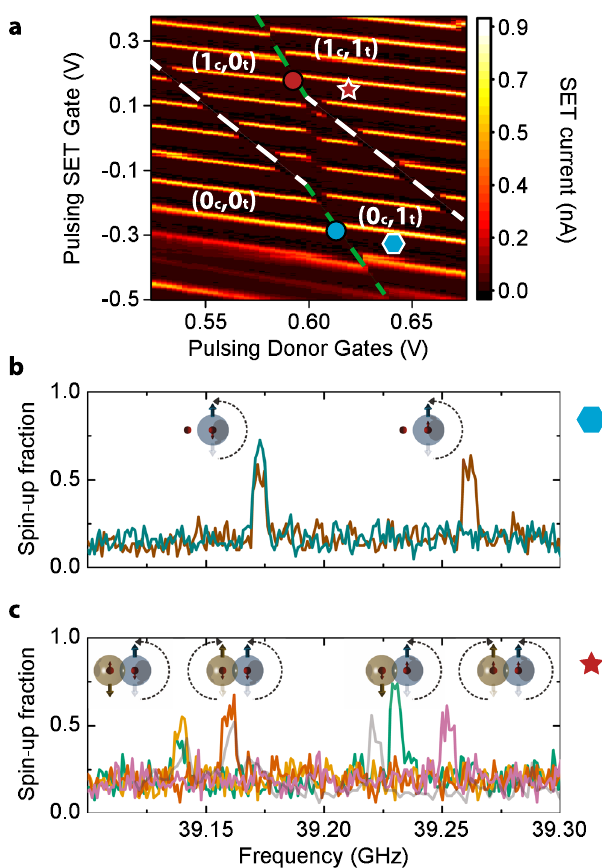
Fig. 4 Signature of exchange coupling between electron spins in a 31 P donor pair. a Charge stability diagram around two donor charge transitions, obtained by scanning the voltages on the pulsing SET and the pulsing donor gates (unlike Fig. 3b, where the DC gates were scanned, which have stronger capacitive coupling to the donors). A clear two-electron honeycomb diagram can be resolved. The dashed white lines follow the control donor transition, while the dashed green lines follow the target donor. The measurement demonstrates an access to all charge occupation regions. Blue and red circles mark the spin readout points for the target electron, while the blue hexagon and red star mark the spin control regions for different charge occupations. b ESR spectrum acquired in the (0 c ,1 t ) region (blue hexagon), i.e., with the control donor ionized. Only two ESR peaks arise, related to the nuclear spin con fi guration of the target donor. c If the ESR spectrum of the target donor is measured in the (1 c ,1 t ) region (red star), the exchange coupling with the control electron gives rise to the four main peaks ℓ 1 (yellow), ℓ 2 (red), ℓ 4 (green), and ℓ 5 (pink), corresponding to the four possible nuclear spin con fi gurations, while the control electron is # (cid:3) (cid:3) (cid:4) . In one scan (gray line), we observed the occurrence of the rare ℓ 5 a transition (see Supplementary Note an exchange interaction J between the two-donor electrons: the four ESR peaks correspond to the four possible orientations of the two donor nuclear spins, while the control donor is in the # j i state ( ℓ 1, ℓ 2, ℓ 4, and ℓ 5). Observing all six main ESR lines would normally require preparing the control donor electron in the " j i state, which was not attempted in this experiment. Here, the nuclear spins ’ state was not deliberately controlled, but all spin con fi gurations were eventually reached through random nuclear fl ips. In one occasion, we also detected an additional ESR peak, consistent with line ℓ 5 a (Fig. 4c, gray line). This resonance represents a (rare) transition from the two-